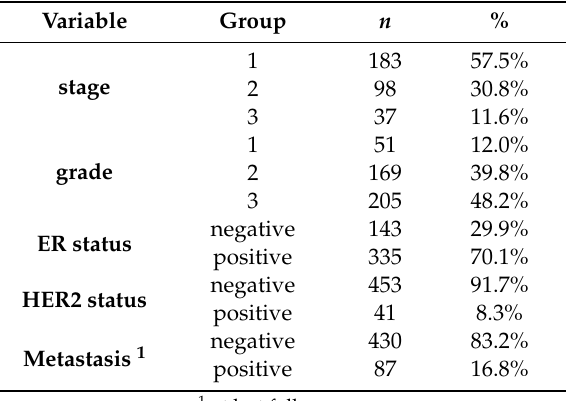
Table 2. Concordance between two independent pathologists for the Nottingham cohort ( n = 516).